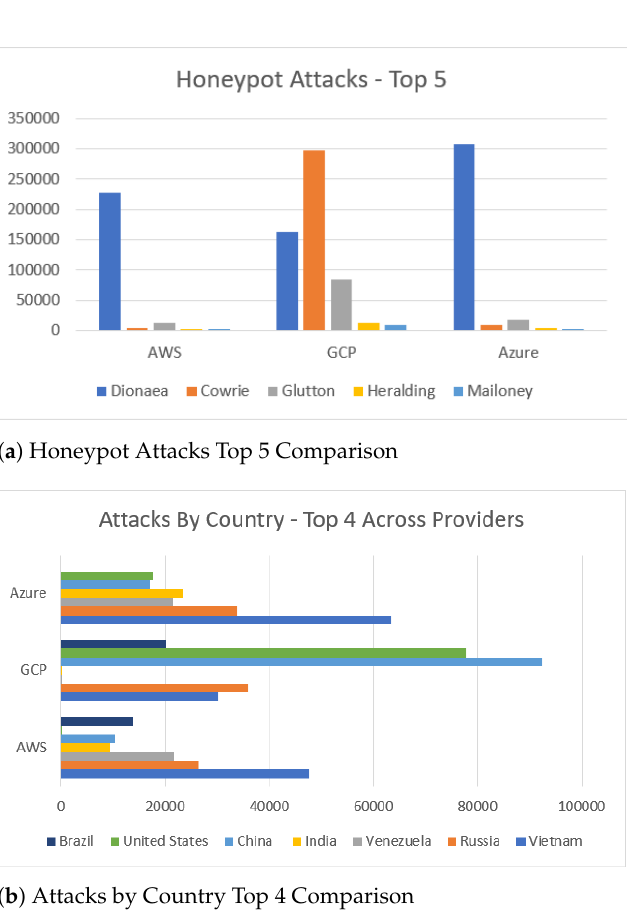
Figure 13. Top Honeypot Attacks Furthermore,